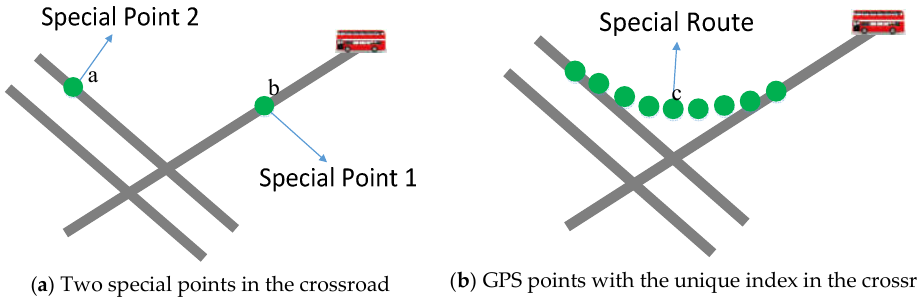
Figure 7. Two special points and GPS points with the unique index in the crossroad.